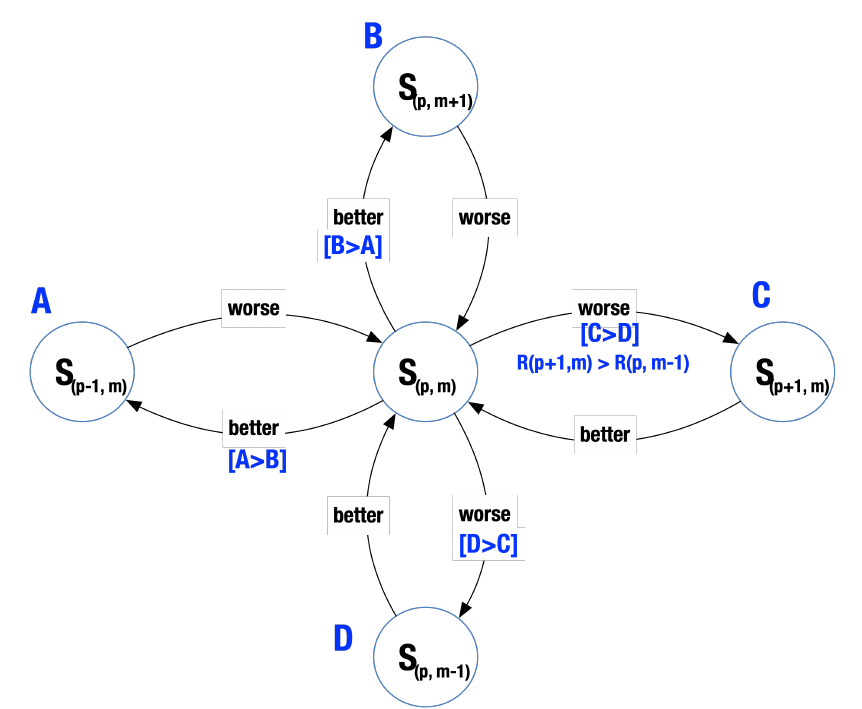
Figure 9. Modification of transmission parameters.